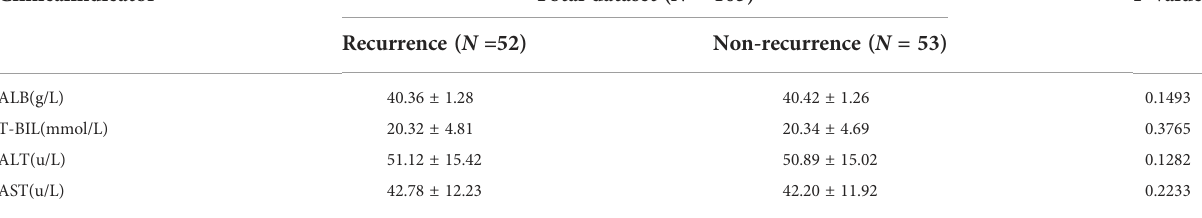
TABLE 1 Statistical results of 4 clinical indicators.